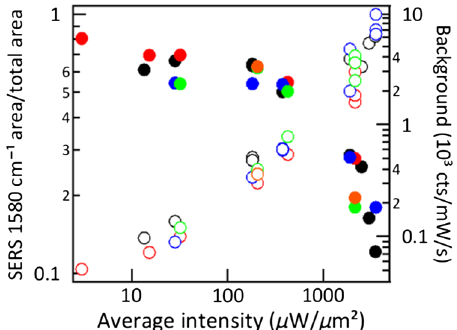
FIG. 11. Extracted relative intensity of the 1580 -cm − 1 Raman mode detected from five individual NPoM (solid dots, left axis) and SERS background extracted at 2000 cm − 1 (open dots, right axis), as a function of increasing CW laser power. Points of different color correspond to different nanoparticles.